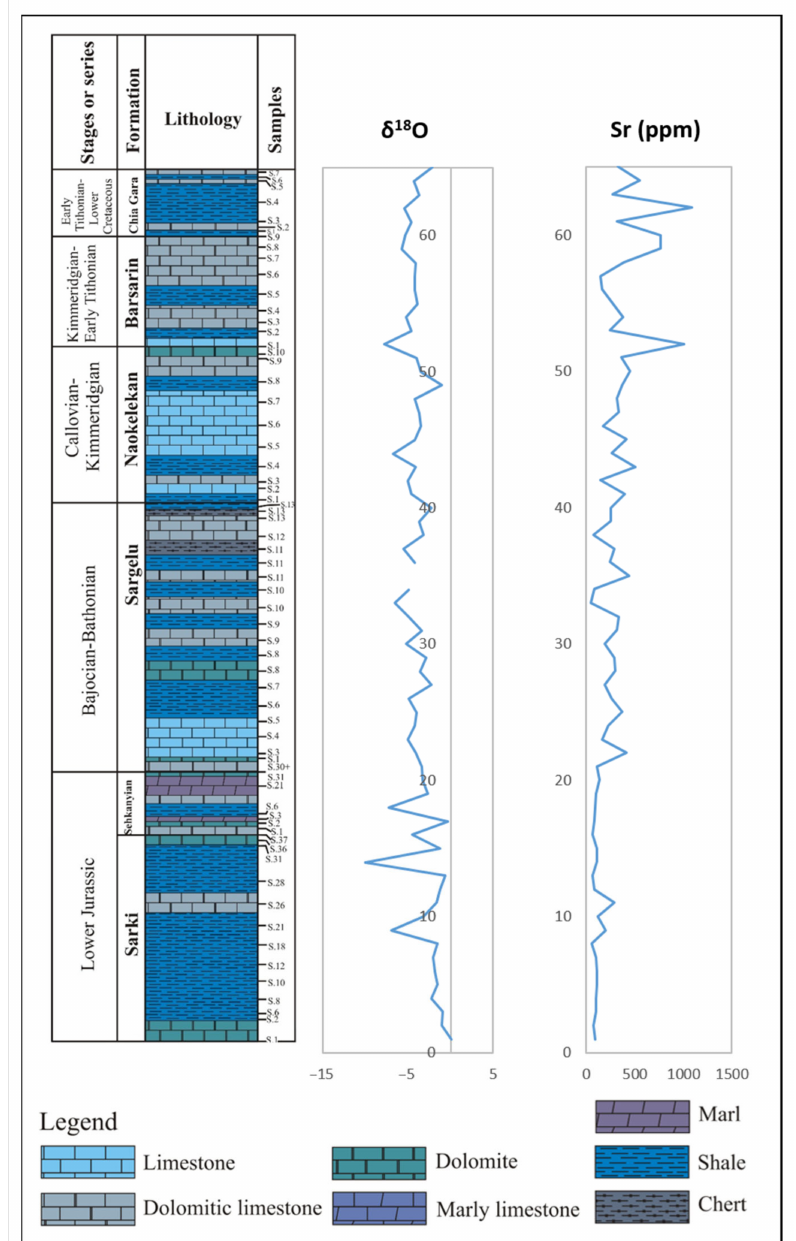
Figure 7. Chart showing geochemical proxies for paleoecological conditions along the measured log of the Warte section, northeastern Iraqi